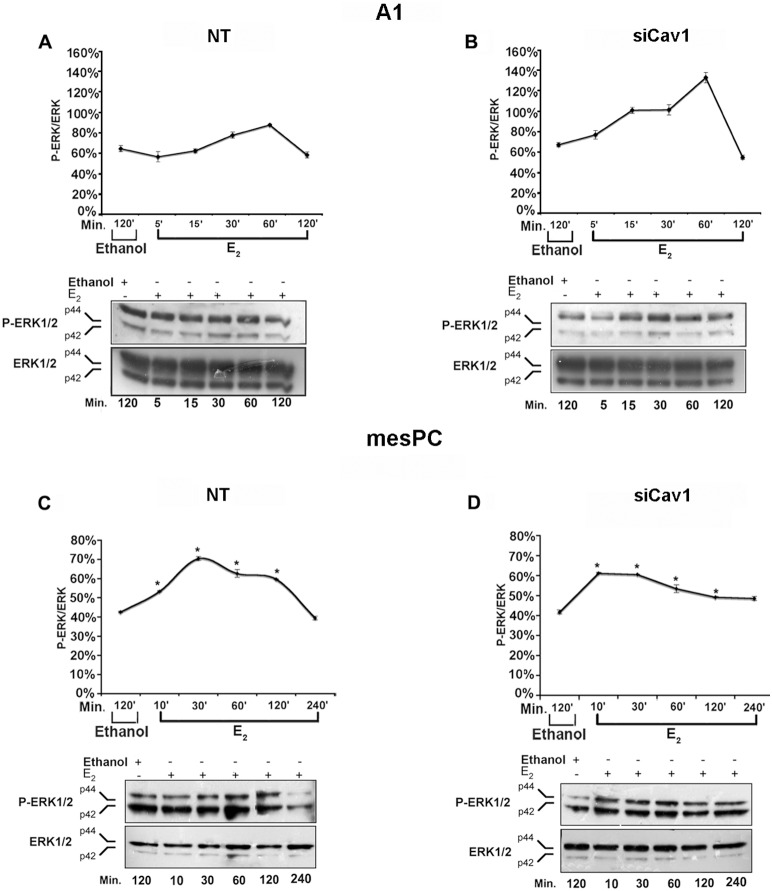
Cav1 downregulation changes the kinetic of p-ERK1/2 activation in non-proliferating mesPC and A1 cells.Western blot detection of p-ERK1/2 and ERK1/2 proteins in non-proliferating A1 cells and mesPC transfected with ON-TARGET plus SMART pool, as a negative control (A, C) and Cav1 specific siRNAs (B, D) treated at indicated time with 10 nM of E2. Two specific bands were observed respectively at 44 and 42 kDa. Each blot is representative of three separate experiments. Data are expressed as ratios of p-ERK1-2/ERK1-2. Asterisks represent p<0.01 when compared to control cultures treated with vehicle (ANOVA, Scheffè F-test).